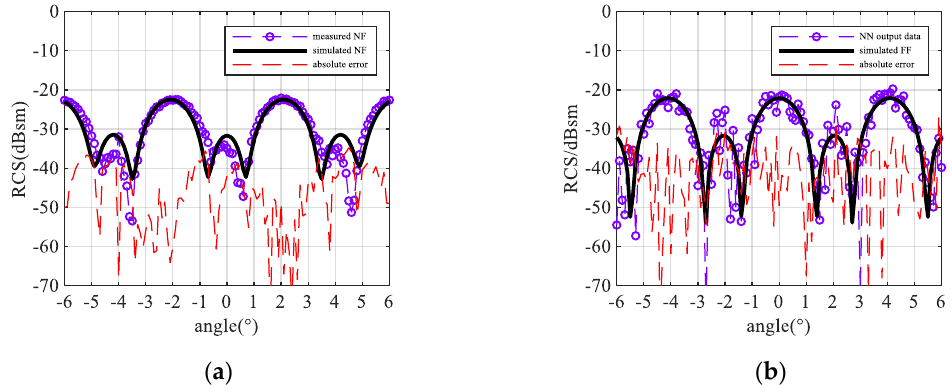
Figure 12. Sphere diameter = 25 mm (0.83 λ ), R = 0.21 m (7 λ ) result: ( a ) near-field measurement result and absolute error; ( b ) NN output result and absolute error.